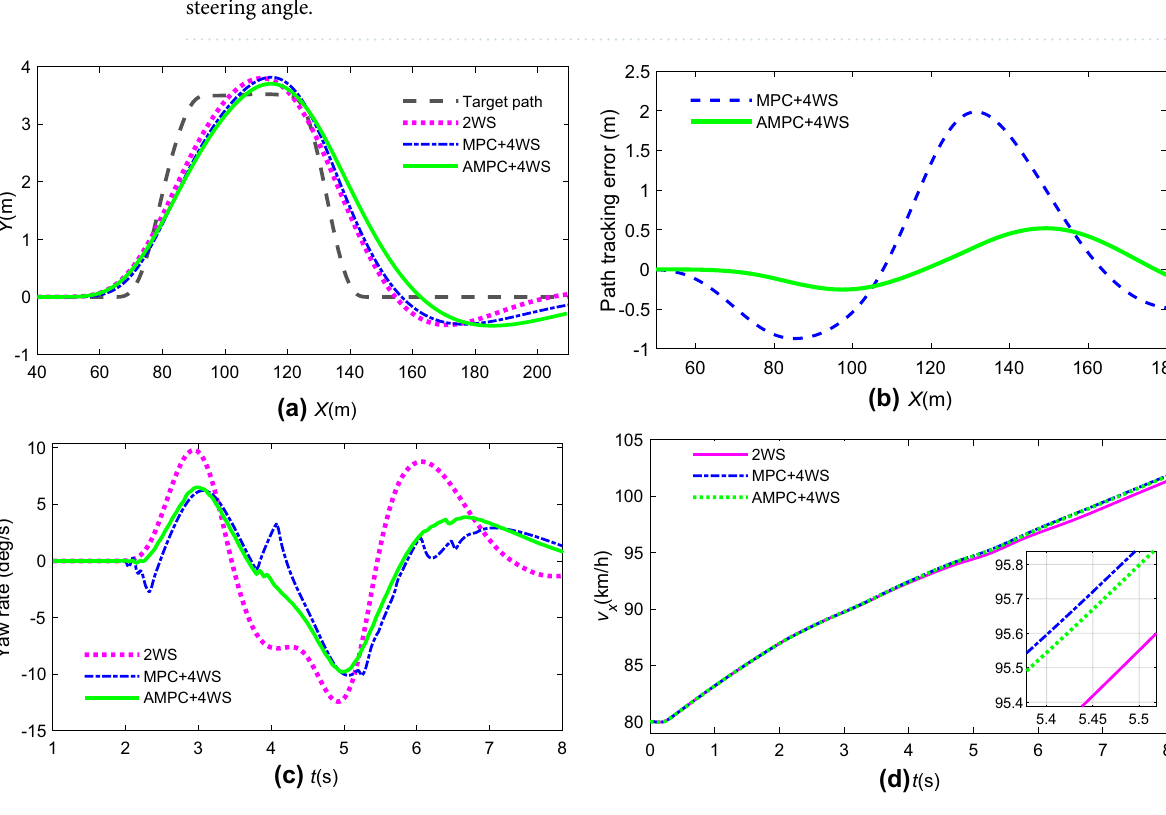
Figure 15. Path tracking and state response by different controllers: ( a ) path tracking; ( b ) path tracking error; ( c ) yaw rate; ( d ) vehicle longitudinal